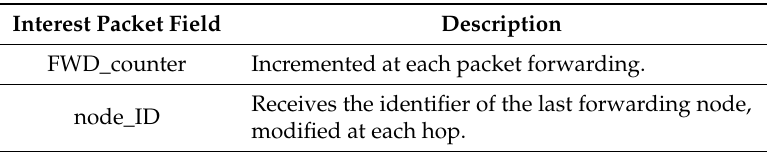
Table 1. New fields added to the interest packet